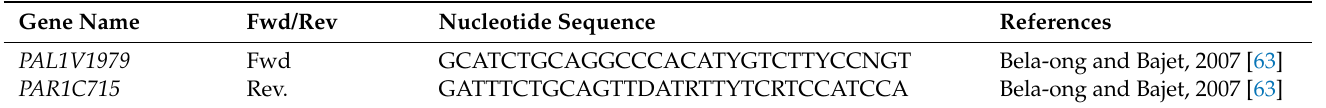
Table 2. Primer sequence used for molecular characterization of PaLCuV-infected